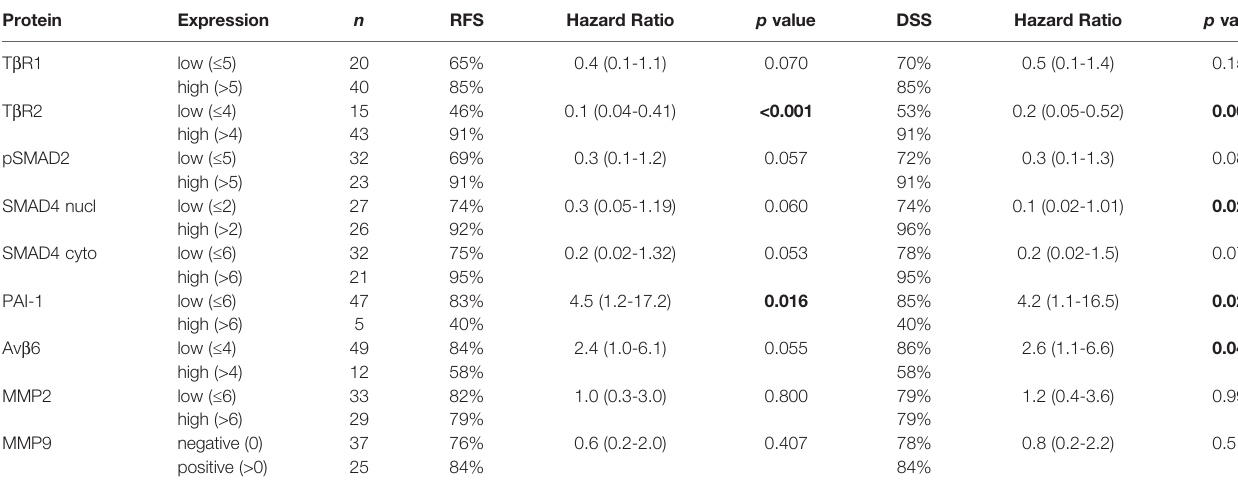
TABLE 3 | Univariate survival analysis. Protein